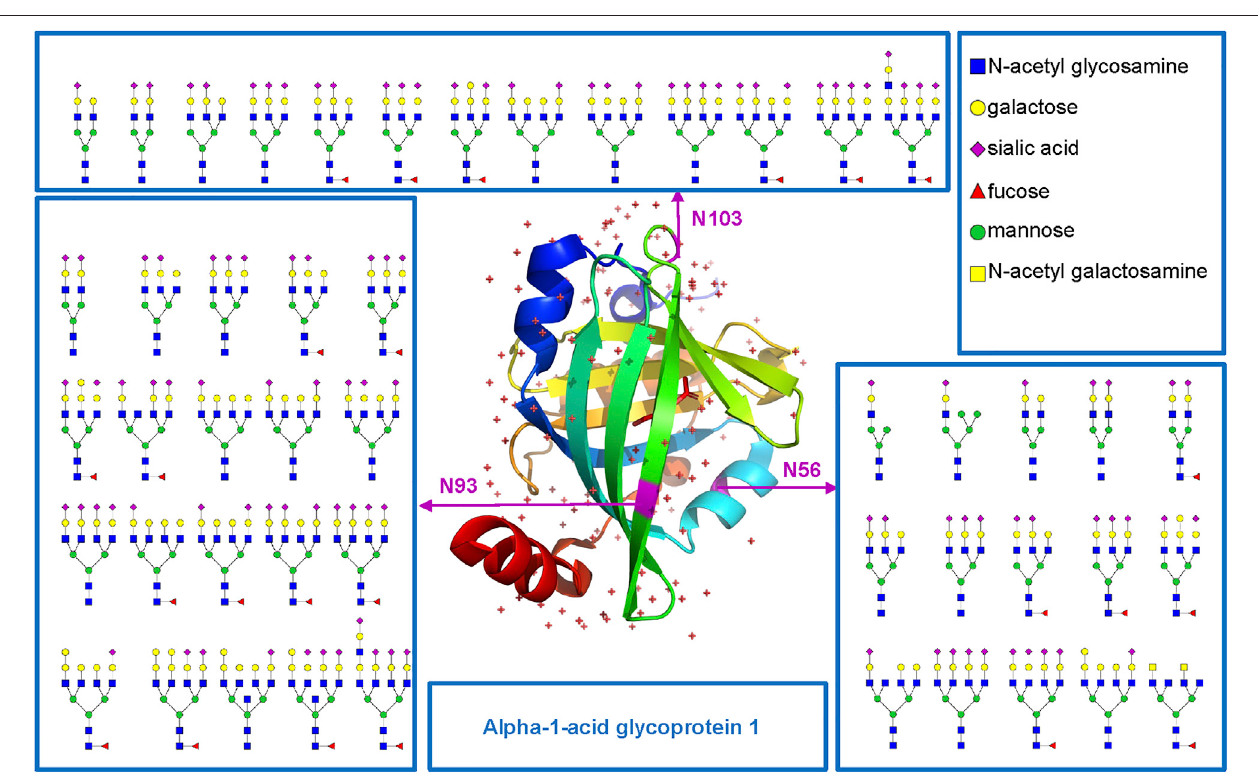
FIGURE 5 | N-glycosites (N56, N93, and N103) and deduced N-glycans were mapped in the three-dimensional structure of the alpha-1-acid glycoprotein 1 (PDB code: 3KQ0) from human